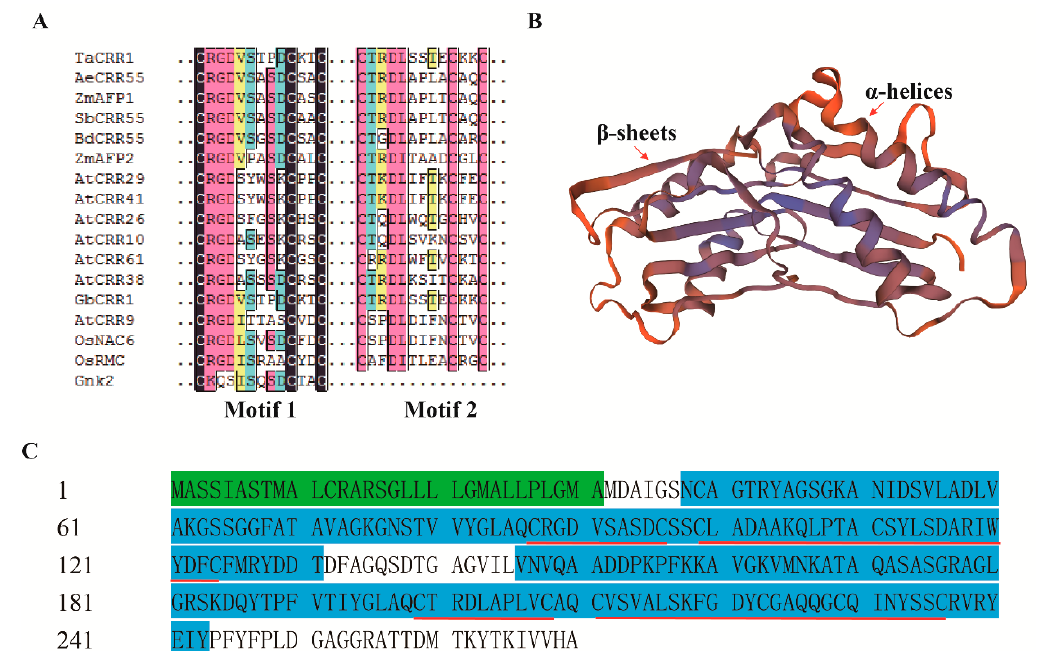
Figure 3. Domain and structure analyses of TaCRR1. ( A ) Amino acid alignment of CRR motifs between TaCRR1 and other CRR proteins. ( B ) The structure model of TaCRR1 protein. The structure of TaCRR1 protein was modeled using the Swiss-Model. ( C ) Schematic diagram of the domain (color area) and cysteine bridge of TaCRR1 protein. The green region indicated signal peptide domain; the blue region indicated DUF26 domain; the red underline indicated the cysteine bridge.